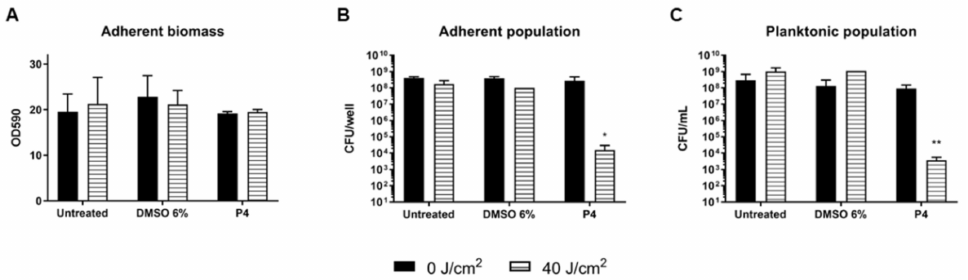
Figure 6. Assay of eradication of S. aureus ATCC 6538P biofilm by porphyrin P4 (30 µ M) upon irradiation with light at 410 nm (40 J/cm 2 ). Adherent biomass of biofilm upon PDT is repre- sented as OD590 ( A ) and cell viability is expressed as CFU/well for adherent population ( B ) and as CFU/mL for planktonic biomass ( C ). Values represent the mean of at least three independent experiments ± the standard deviation. Statistical analyses using one-way ANOVA were performed between treated samples and reference untreated control (* p < 0.05; ** p <